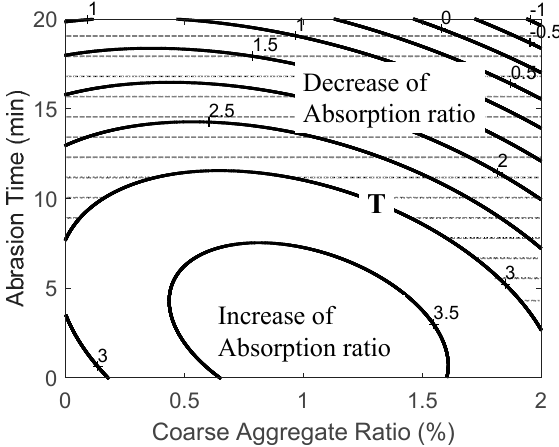
Figure 7. Analysis response surface for the absorption ratio of recycled fine aggregate derived from the coarse aggregate ratio and abrasion time.